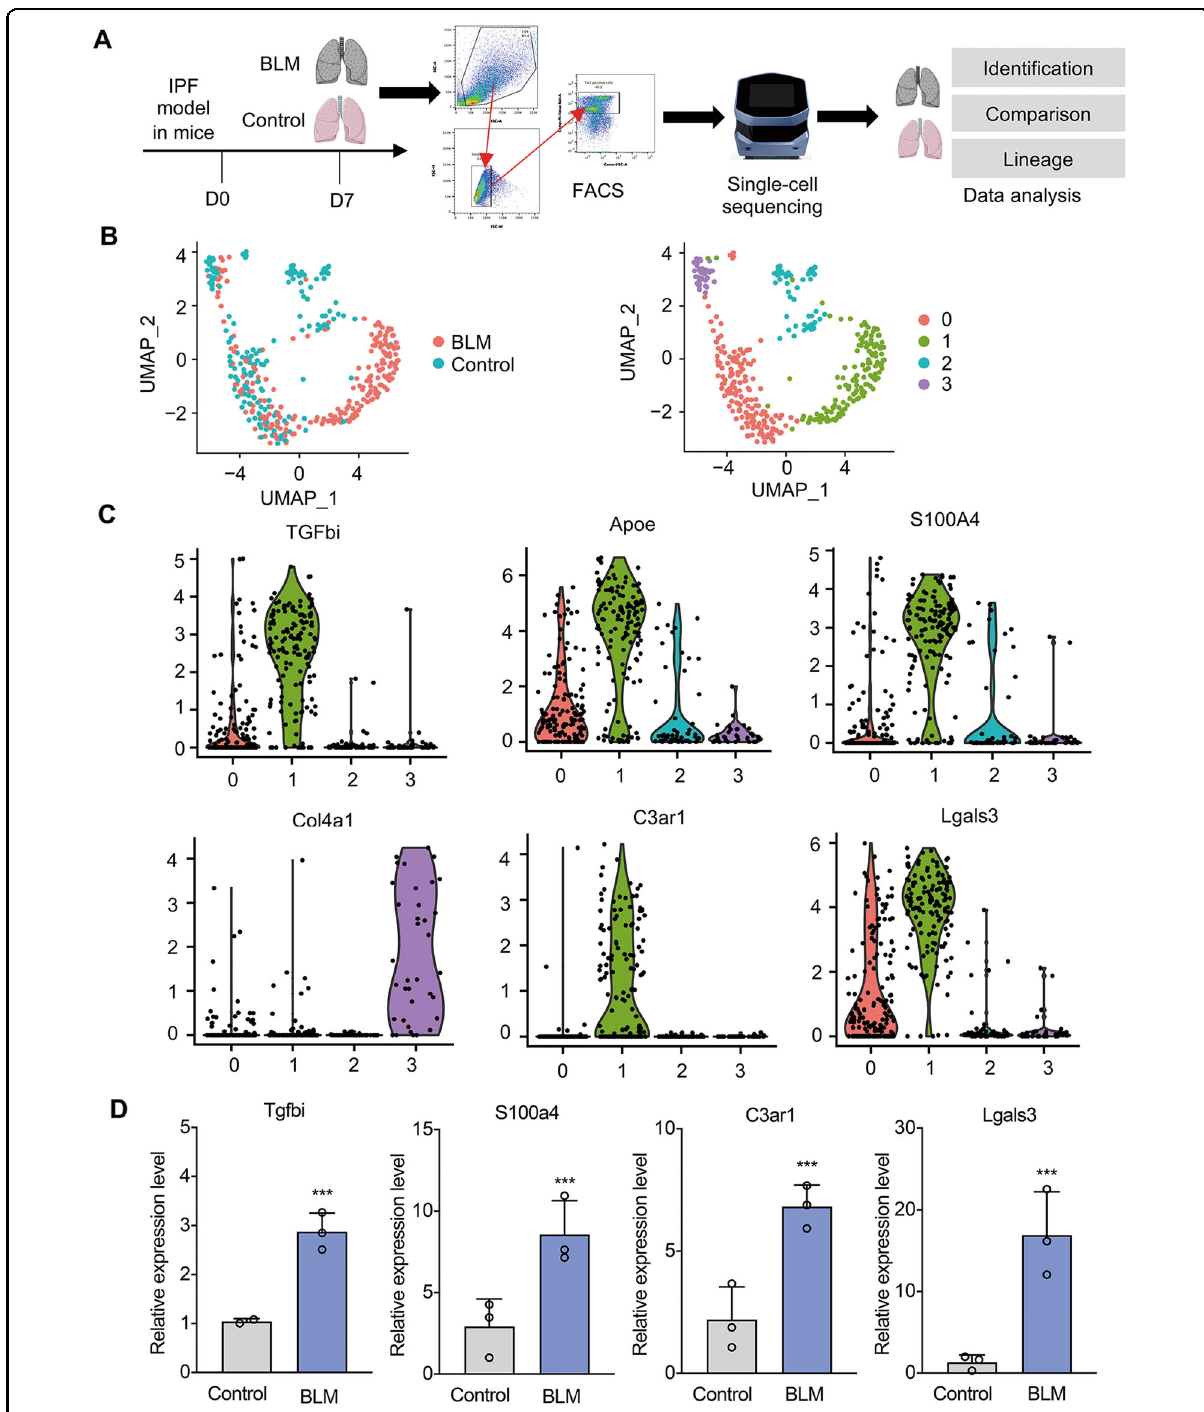
Fig. 2 Transcriptional heterogeneity of ECs during EndMT in IPF at single-cell level. A Sing-cell transcriptome sequencing (scRNA-seq) using the Fluidigm C1 platform. Lung cells from the BLM and control groups were collected and sorted by FACS to harvest Tie2 + cells for scRNA- seq. B UMAP visualization of single-cell transcriptomes in the BLM and control groups. Left panel: colored by origin of cells (BLM or control). Right panel: colored according to the unsupervised clustering of cells. C Cluster-wide expression of EndMT-related markers/regulators screened among differentially expressed genes of high signi fi cance ( p < 0.01) based on their GO-terms. D Expression levels of candidate regulators in whole lung samples from the BLM (day 7) and control groups according to RT-PCR. The data are presented as means ± SD, n = 3. * p < 0.05, ** p < 0.01, *** p <